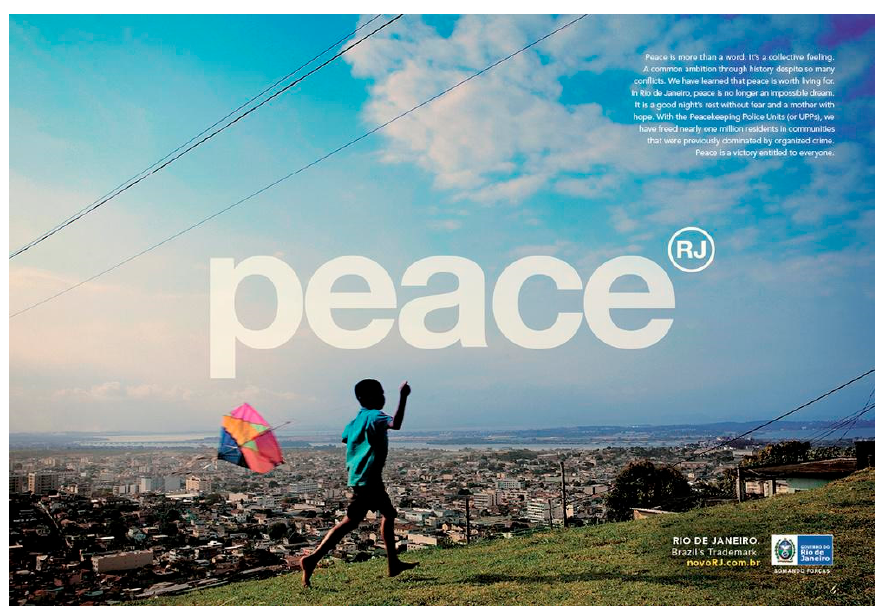
Figure 3. Advertising campaign piece based on the “RJ” logo launched internationally.